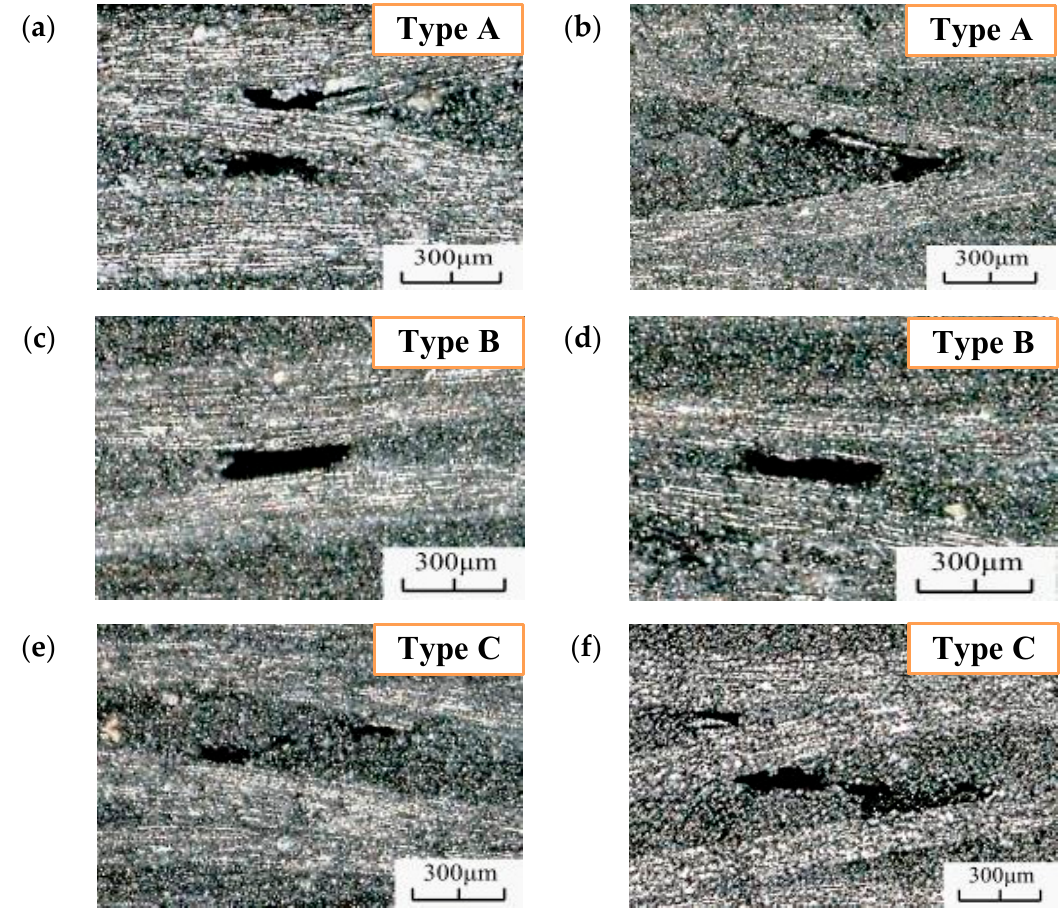
Figure 12. Fatigue characterization in the VHCF regime for ( a ) N = 5.52 × 10 8 , R = 0.35, ( b ) N = 1.26 × 10 8 , R = 0.35, ( c ) N = 3.46 × 10 8 , R = 0.35, ( d ) N = 8.64 × 10 8 , R = 0.2, ( e ) N = 2.23 × 10 9 , R = 0.2, and ( f ) N = 3.55 × 10 9 , R = 0.2.